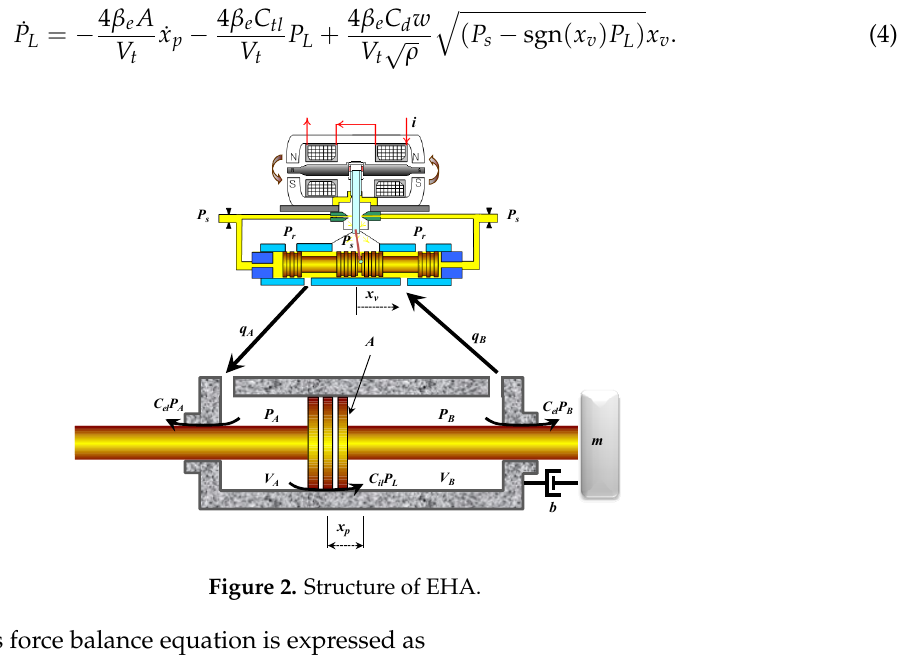
Figure 2. Structure of